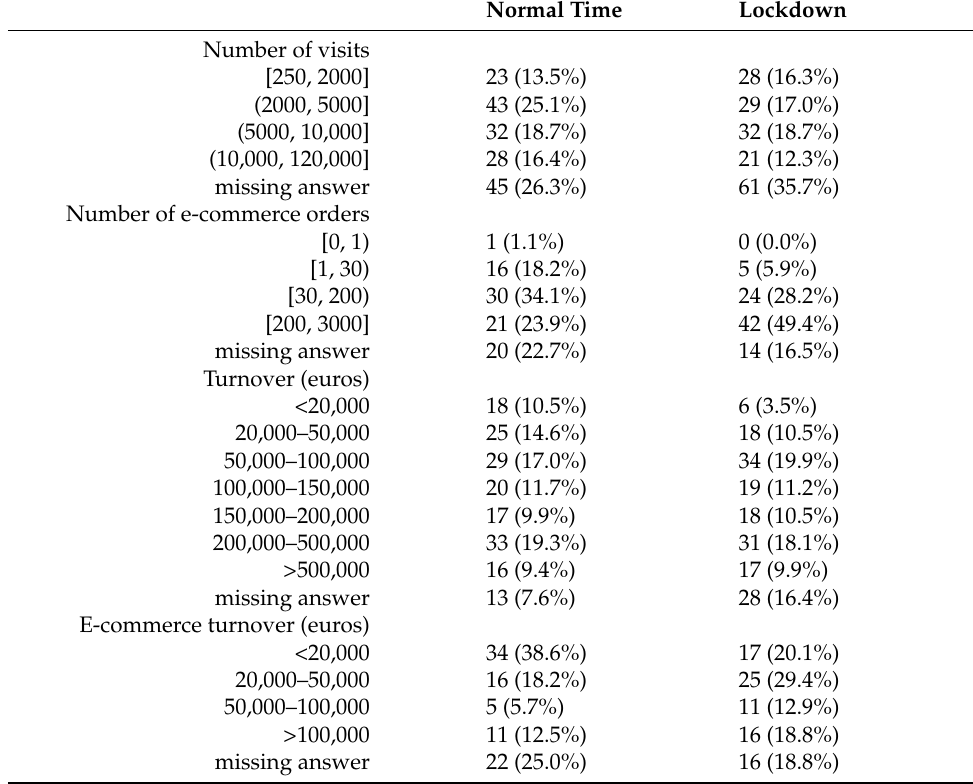
Table 5. Description of orders and turnover (normal time vs. lockdown). All chi-squared p -values comparing the two groups are <0.05. The percentage is calculated over n = 171 supervisors for the number of visits and the turnover and over those concerned by e-commerce: n = 88 at normal time and n = 85 during the lockdown (see Appendix A (Table A3) for